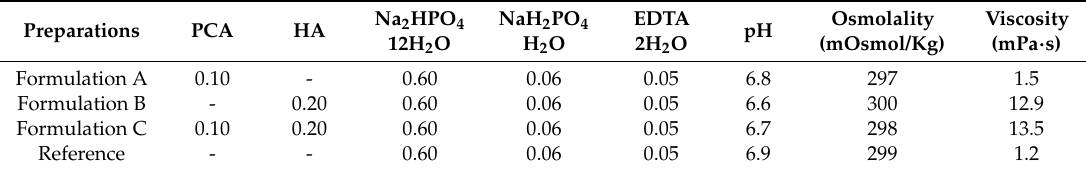
Table 1. Composition (% w/w ) and technological parameters of the formulations under